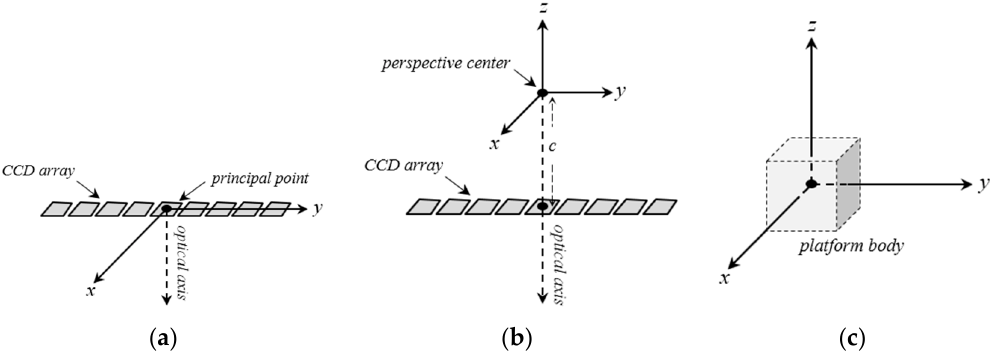
Figure 1. The coordinate systems used in the MPC: ( a ) The IRF; ( b ) The SRF; ( c ) The PRF.